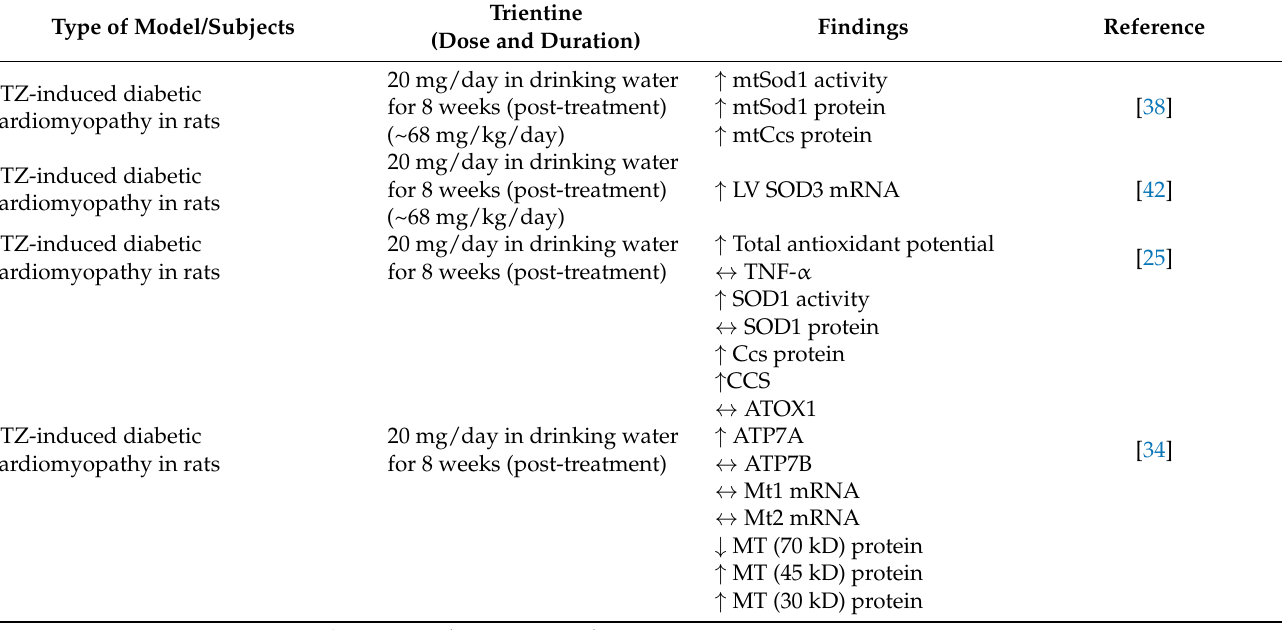
Table 4. Effects of trientine on myocardial oxidative stress and inflammation in animal studies. Trientine Type of Model/Subjects Findings (Dose and Duration)